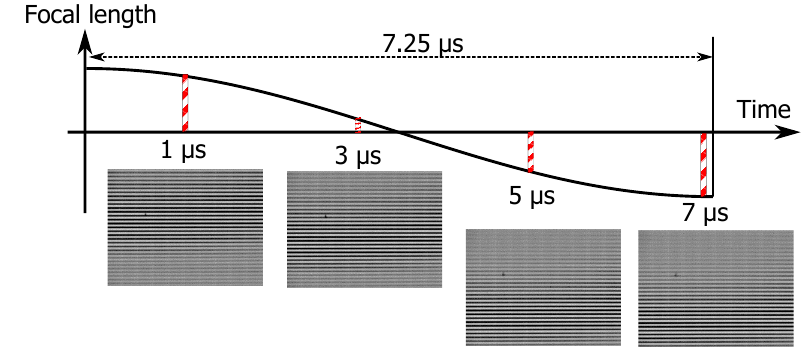
Figure 8. Relation between focal length of TAG lens and captured